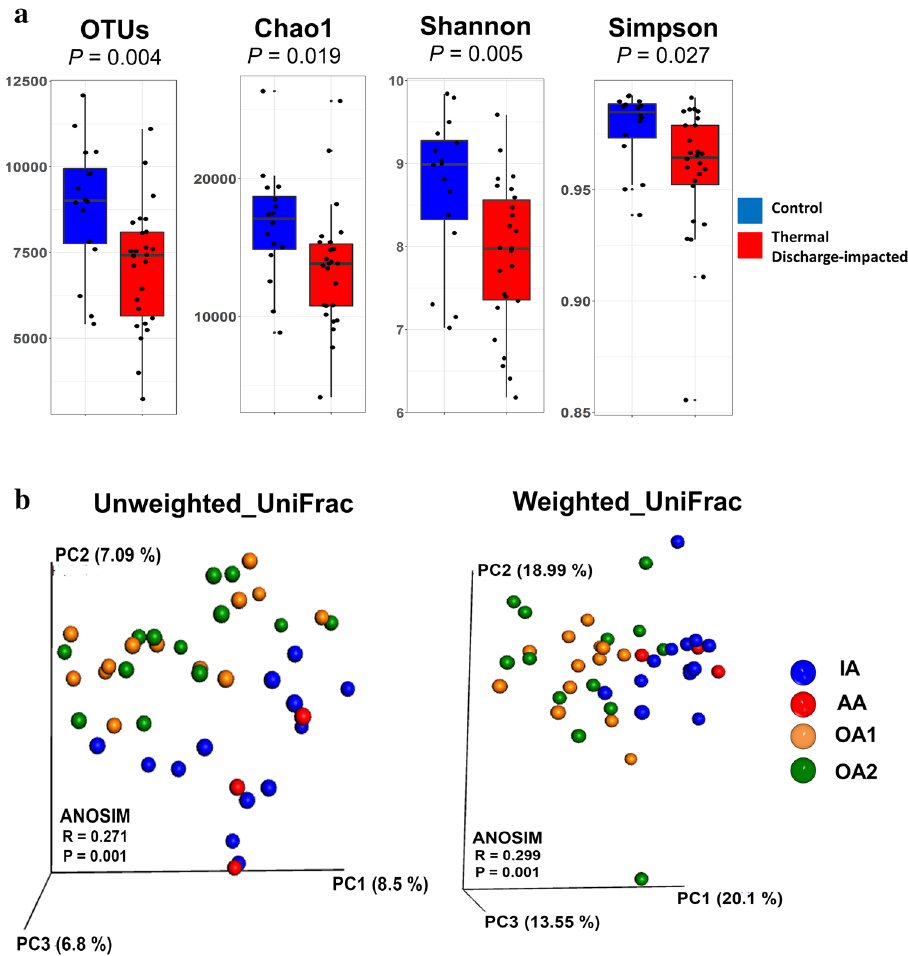
Figure 1. Bacterioplankton richness and community composition variations between control and thermal discharge-impacted samples. ( a ) Box plots displaying the alpha-diversity (OTUs, Chao1, Shannon, and Simpsons) comparison between the control (n = 16) and thermal discharge-impacted (n = 26) groups. The bacterioplankton richness and evenness of control and thermal discharge-impacted samples are clearly distinct (Student’s t-test, p < 0.05). ( b ) Principal coordinate analysis (PCoA) plots showing beta diversity variations based on unweighted and weighted UniFrac distance metrics. The bacterioplankton community structure significantly differed between control and thermal discharge-impacted areas as confirmed by ANOSIM ( p <